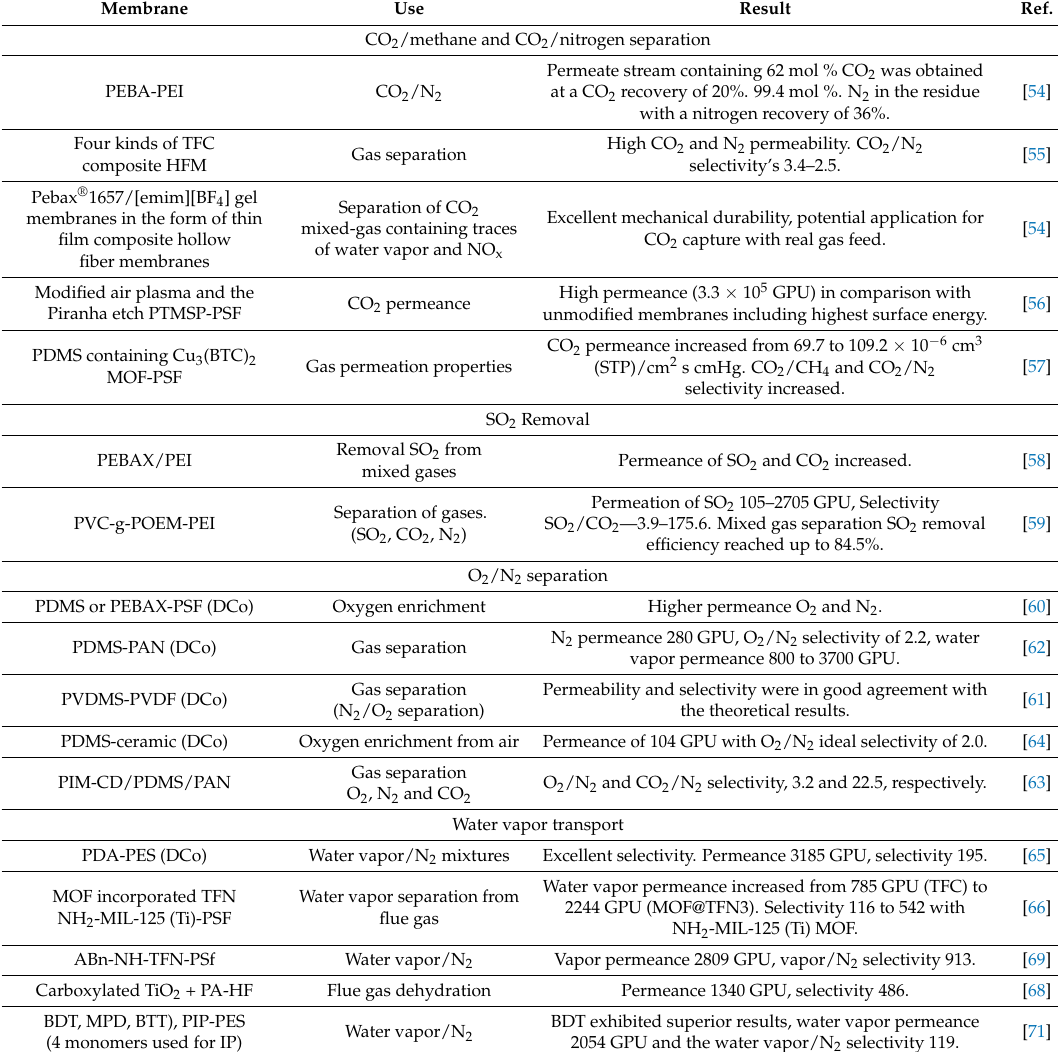
Table 3. TFC hollow fiber membrane for the separation of gas or gas/water vapor mixtures.